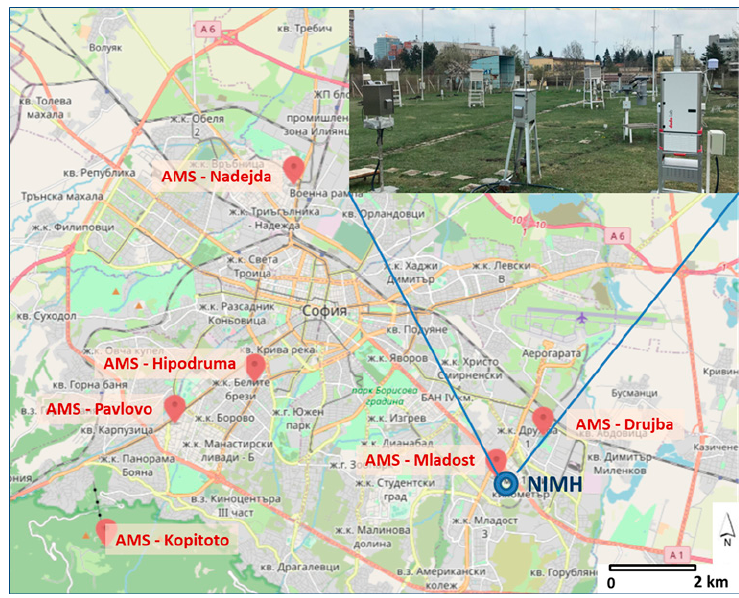
Figure 1. Maps with main point source of SO2/SOx ( a ) and PM10 ( b ) .